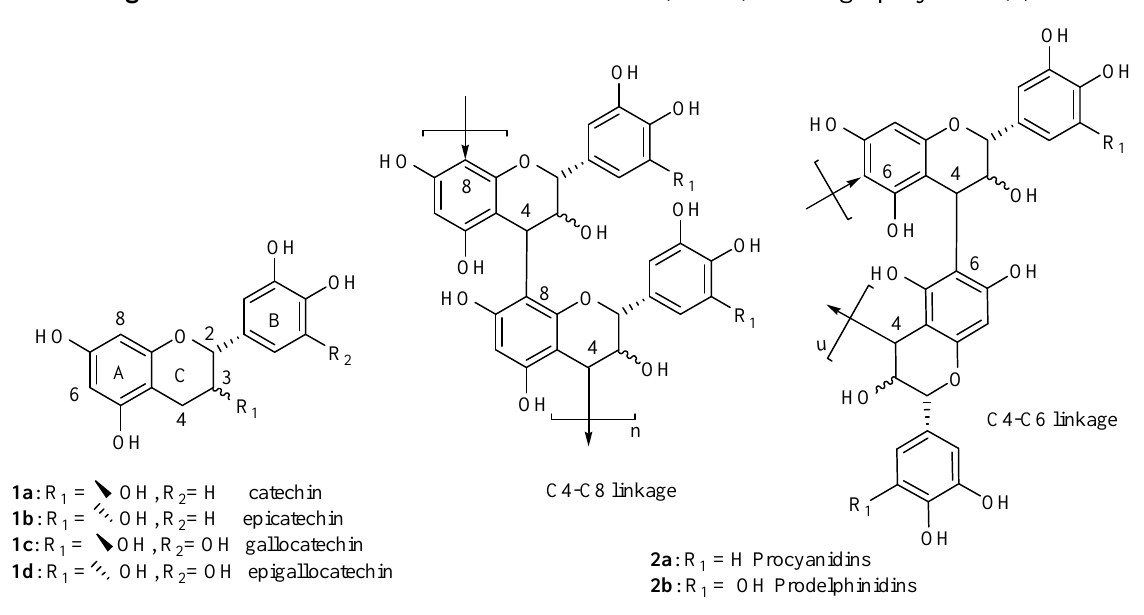
Figure 1. Structures of flavan-3-ol monomers ( 1a - 1d ) and oligo/polymers ( 2